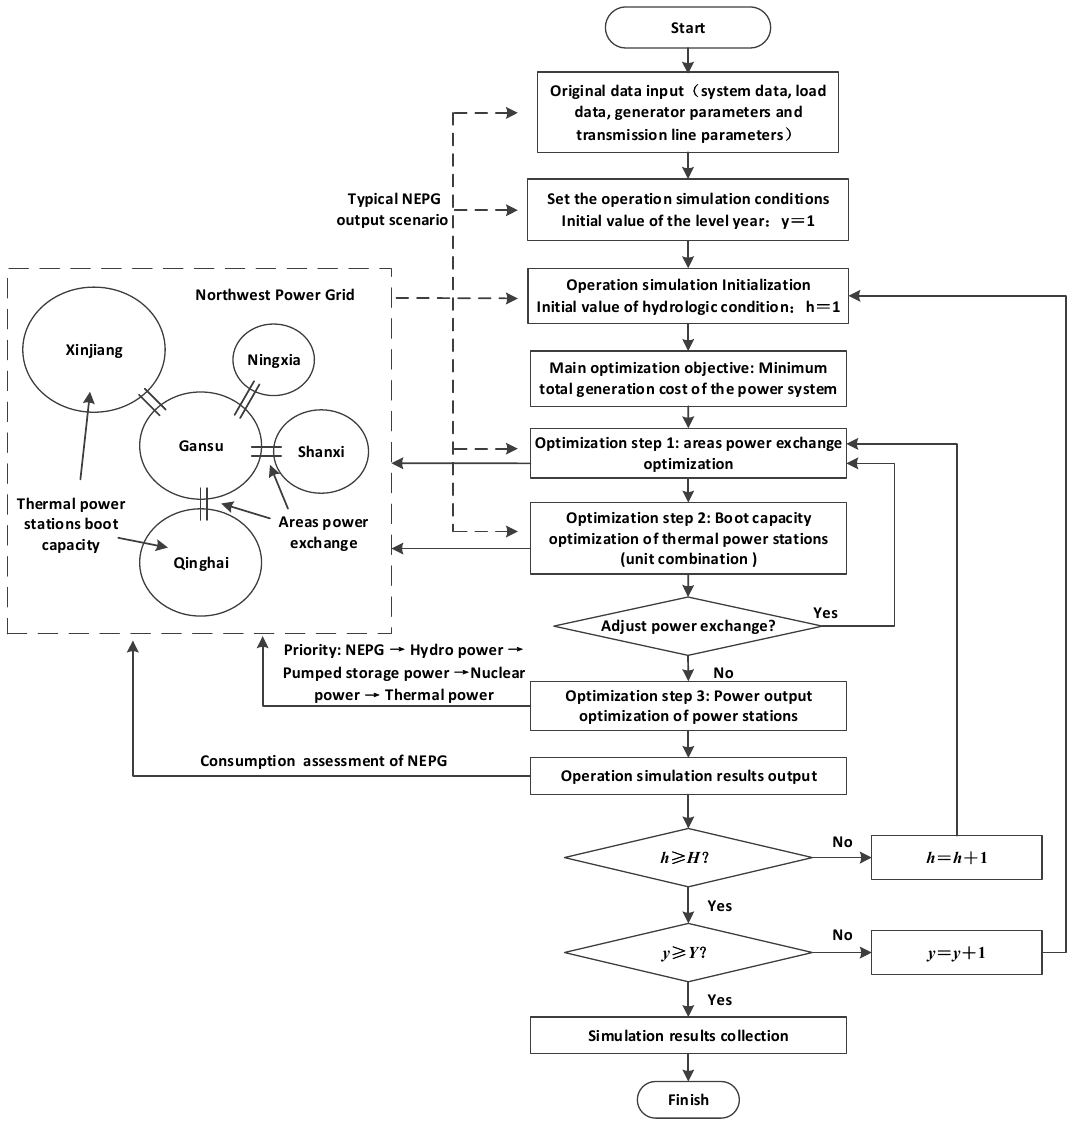
Figure 3. The operation flow diagram of a power system integrated with large ‐ scale new energy power.